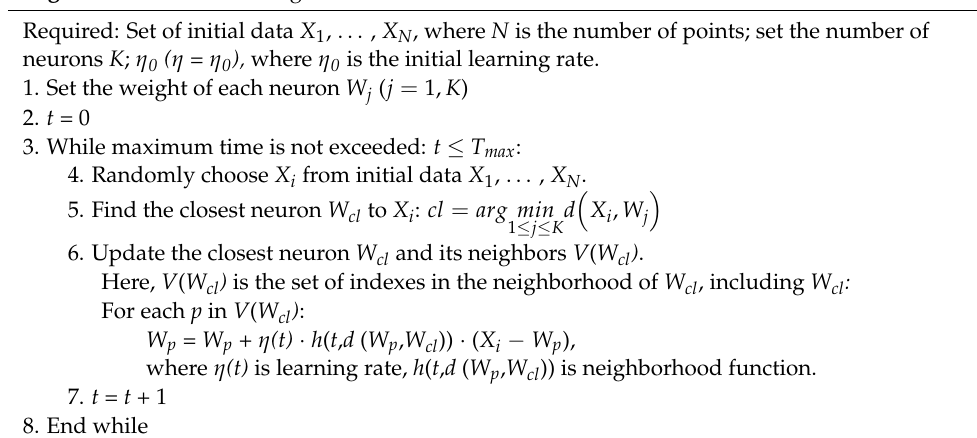
Algorithm 2. Basic SOM algorithm